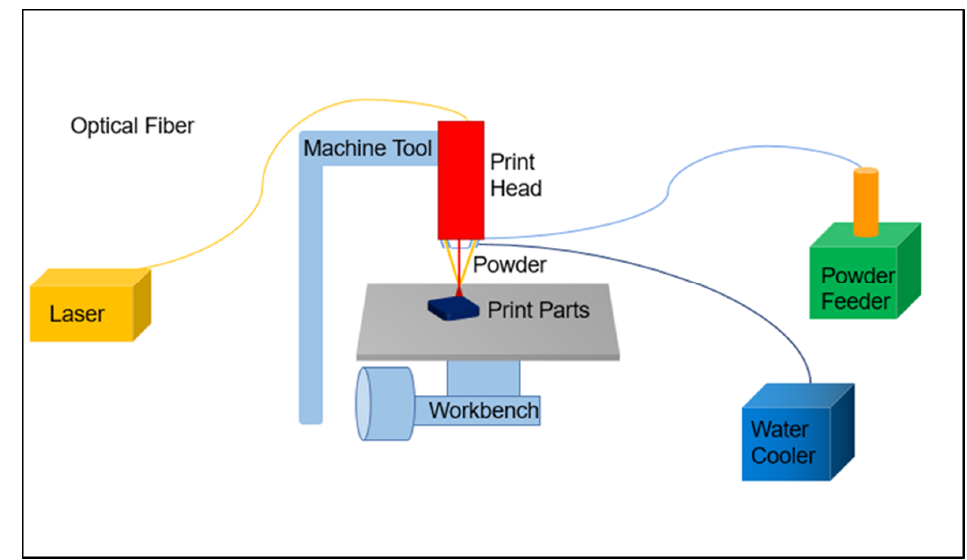
Figure 2. Schematic diagram of LMD.